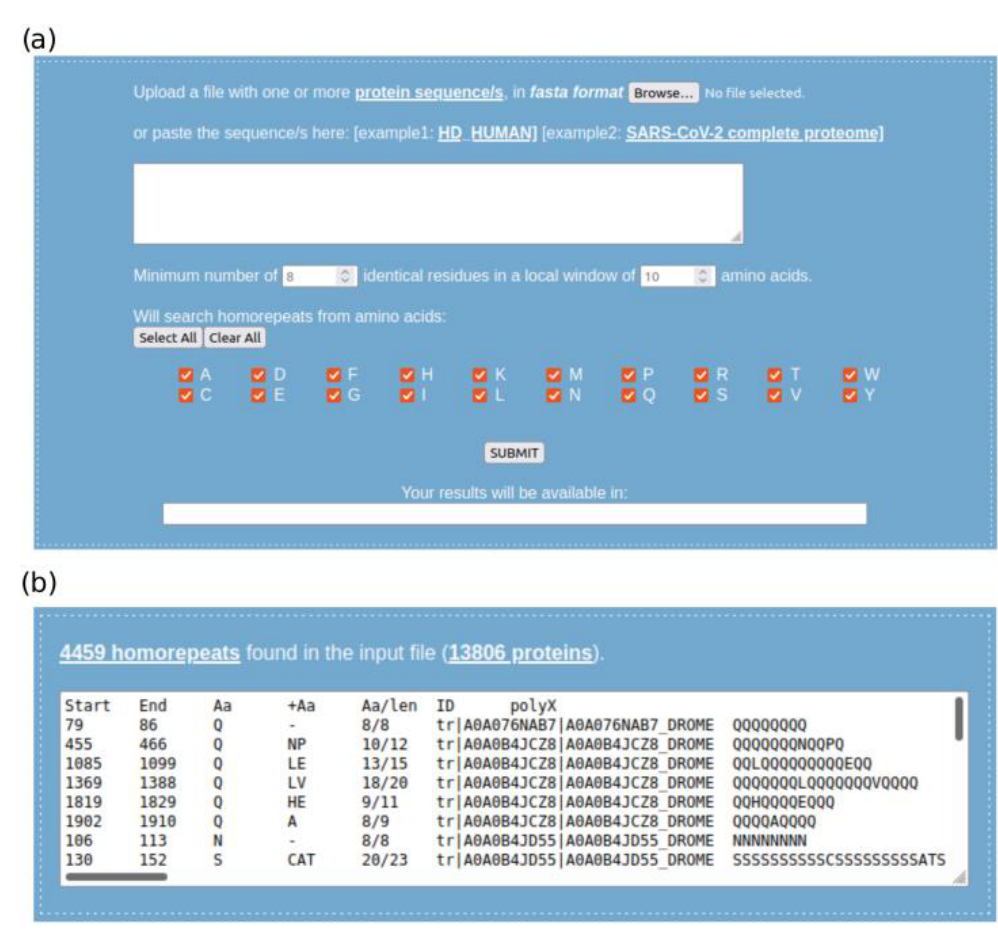
Figure 2. PolyX2 web tool. ( a ) Execution module on home page; ( b ) overview of the results.